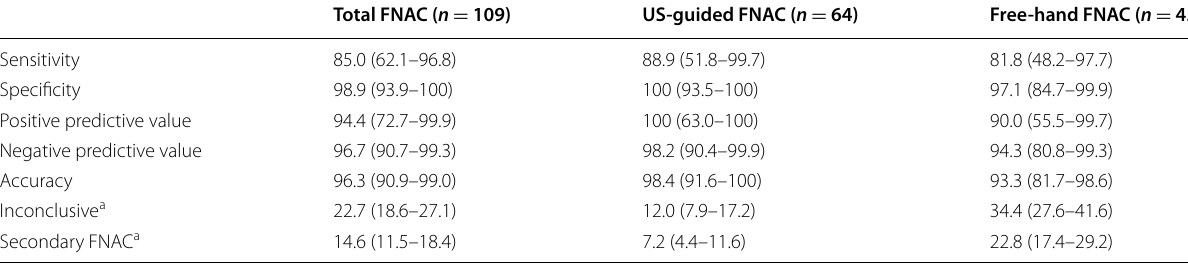
All values presented in % (95% confidence interval) a Total FNAC n